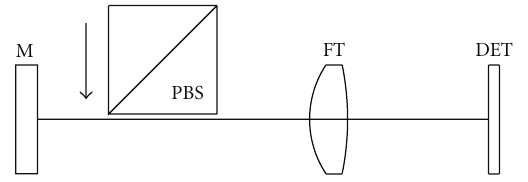
Figure 4: Slope error measurement of the PBS by the LTP MF (shown as FT lens and DET detector). The PBS scans through the test beam of the LTP MF to simulate the BLM.